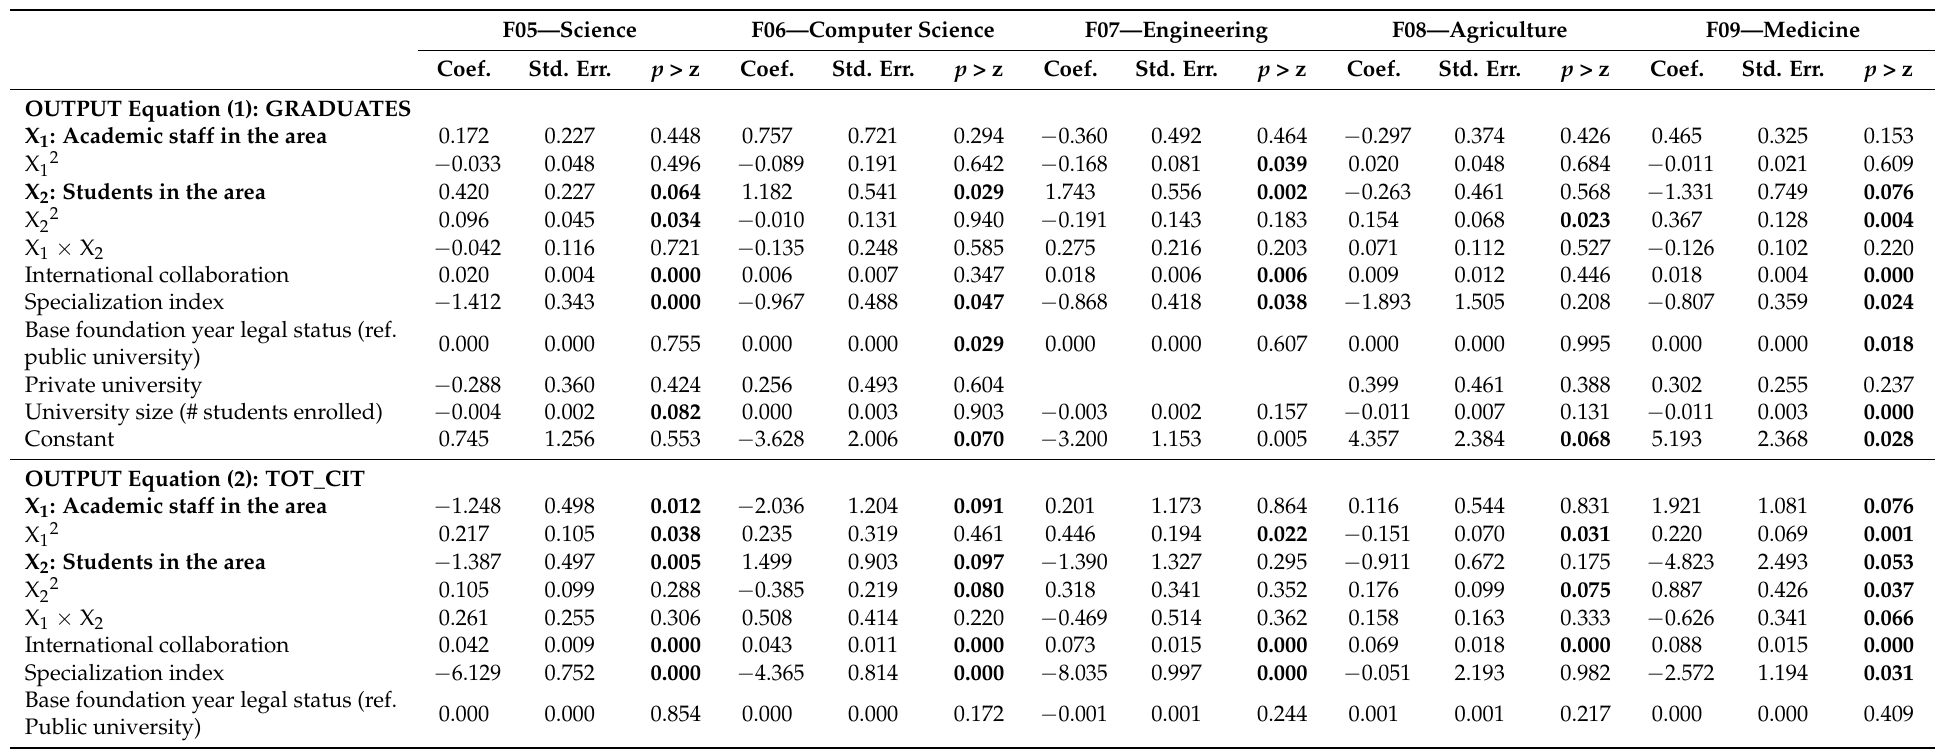
Table 5. SUR estimates: extended Translog function with control